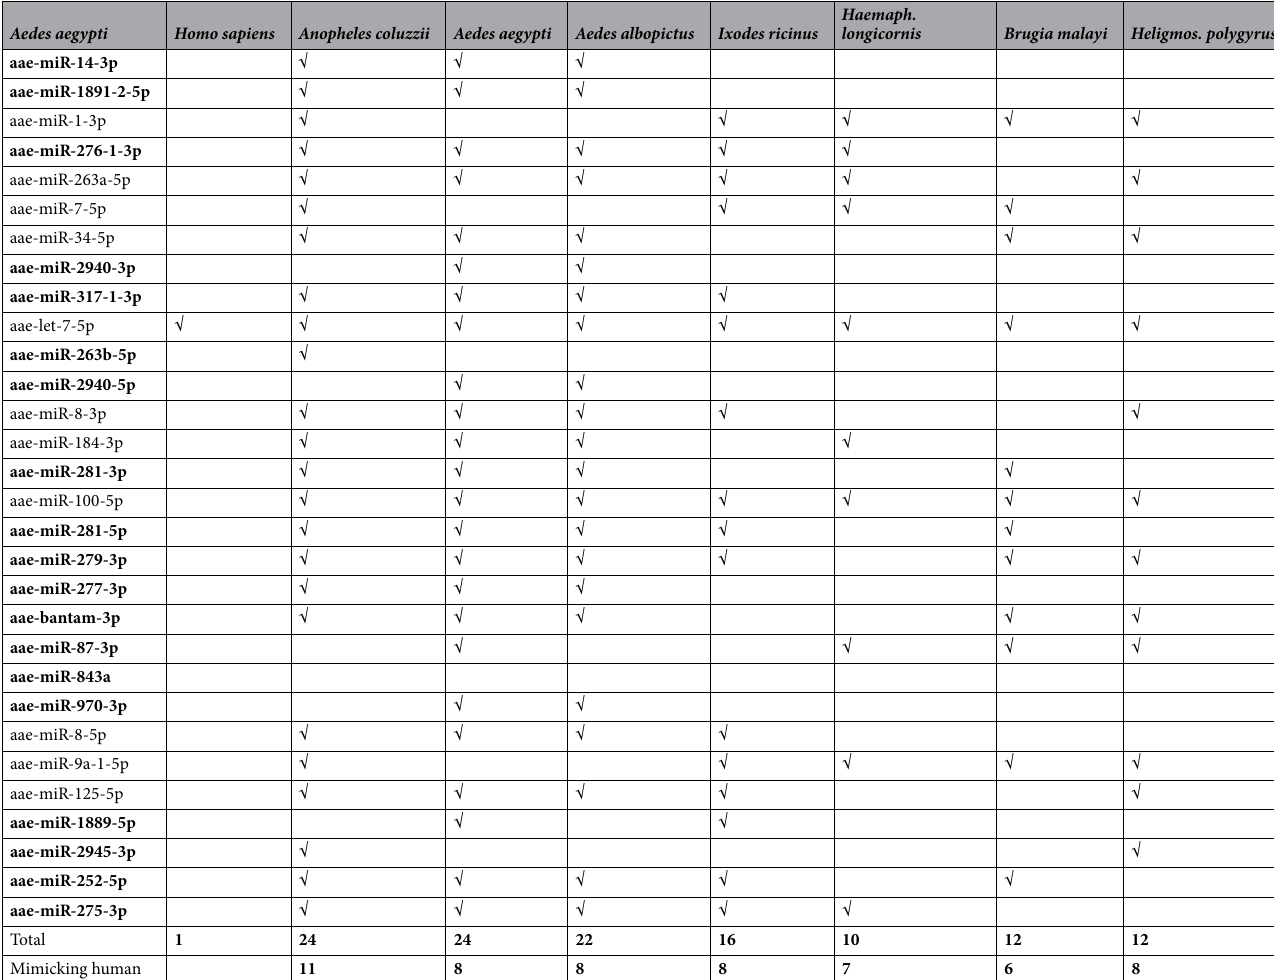
Table 3. Distribution in other species of Aedes aegypti saliva miRNAs found in this study. MicroRNAs homologous to the top 30 miRNAs found in the saliva of Aedes aegypti were searched among the top 50 in human saliva (Yeri et al., 2017), in the saliva of Anopheles coluzzii (Arcà et al., 2019), Aedes aegypti and Aedes albopictus (Maharaj et al., 2015), Ixodes ricinus (Hackenberg et al., 2017), Haemaphysalis longicornis (Malik et al., 2019) and among the top 50 exosomal miRNAs from Brugia malayi (Zamanian et al., 2015) and Heligmosomoides polygyrus (Buck et al., 2014). The total number of conserved miRNAs and of miRNA identical to human miRNAs are shown at the bottom. Aedes aegypti miRNAs identical (or almost identical) to human miRNAs are highlighted in